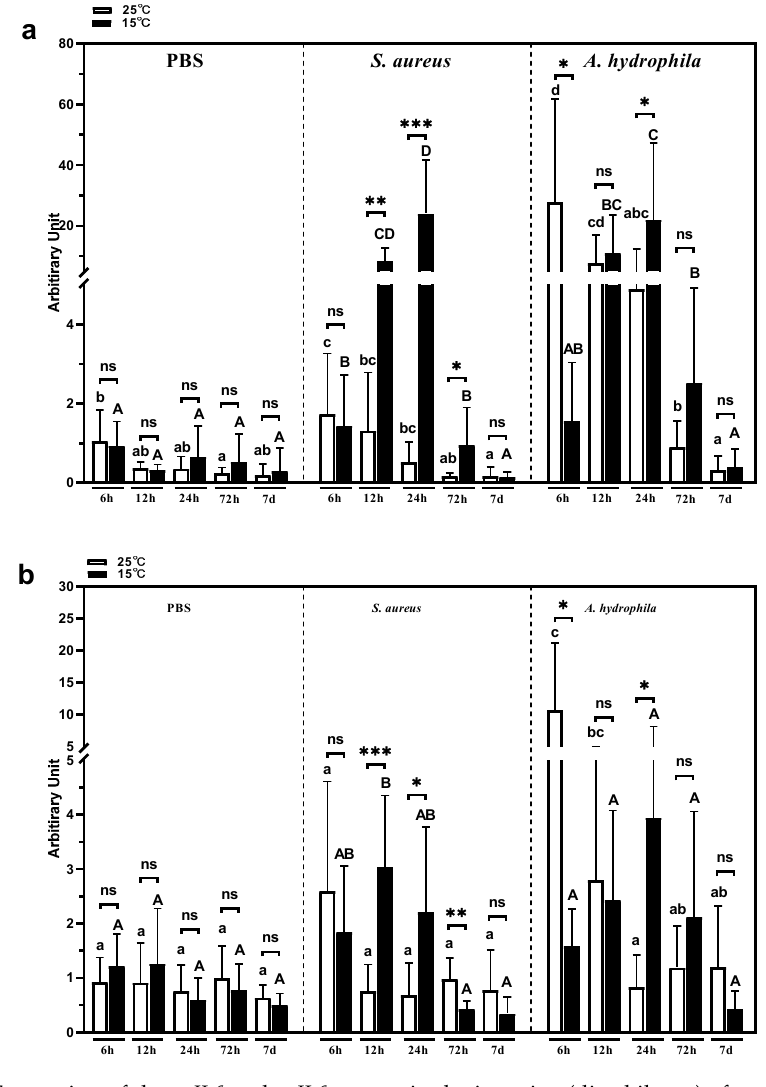
Figure 8. Expression of the psIL6 and psIL6ns gene in the intestine (distal ileum) after S. aureus and A. hydrophila in vivo infection within 7 days after acute cold stress. Capitalized and small letters: Statistical comparison between time points within a treatment group. Di ff erent letter denotes statistically significant di ff erence ( p < 0.05, capitalized vs. capitalized, small letters vs. small letters). ( a ) psIL6 and ( b ) psIL6ns expression. The data are presented as mean + SD (n = 6). * p < 0.05; ** p < 0.01; *** p < 0.001. ns: No statistically significant di ff erence between the treatment groups. Two-way ANOVA